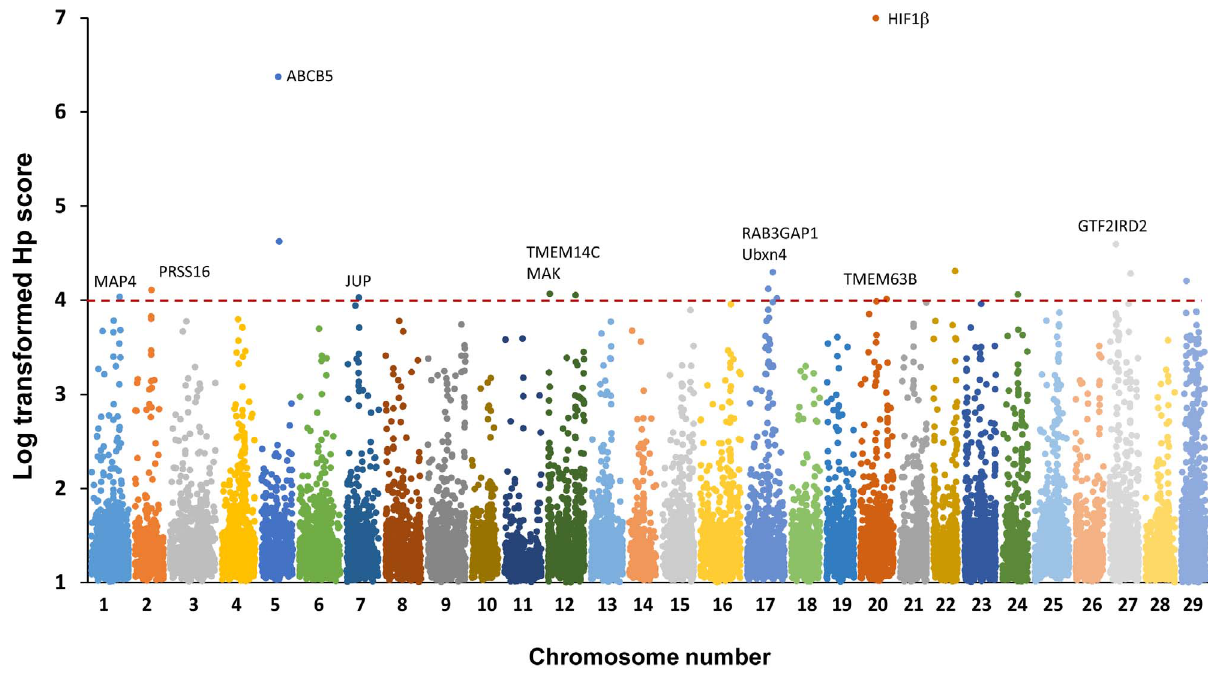
Figure 5. Genome-wide distribution of log-transformed pooled heterozygosity ( Hp ) values. The x-axis represents the positions of windows (20 Kb) along each chromosome, which is represented with different colors. The y-axis represents the Hp scores transformed by –log 2 . Windows of HIF-1 b had the Hp score of 0, therefore, its transformed Hp score was defined as 7, the maximum score, for the convenience of plotting.